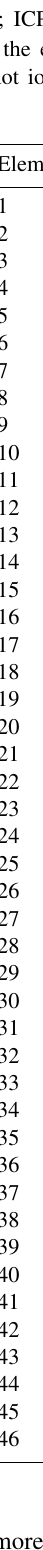
Table 2. Summary of chemical species analyzed in this